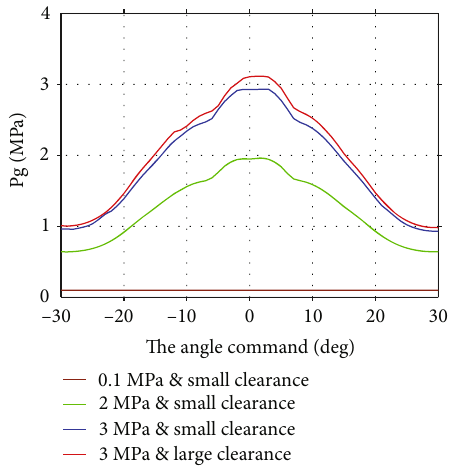
Figure 8: The actual pressure in the GG.